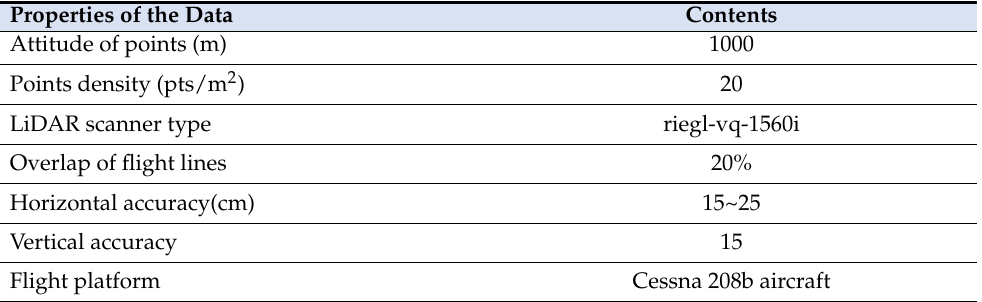
Table 1. The details of the test data in Hupao National